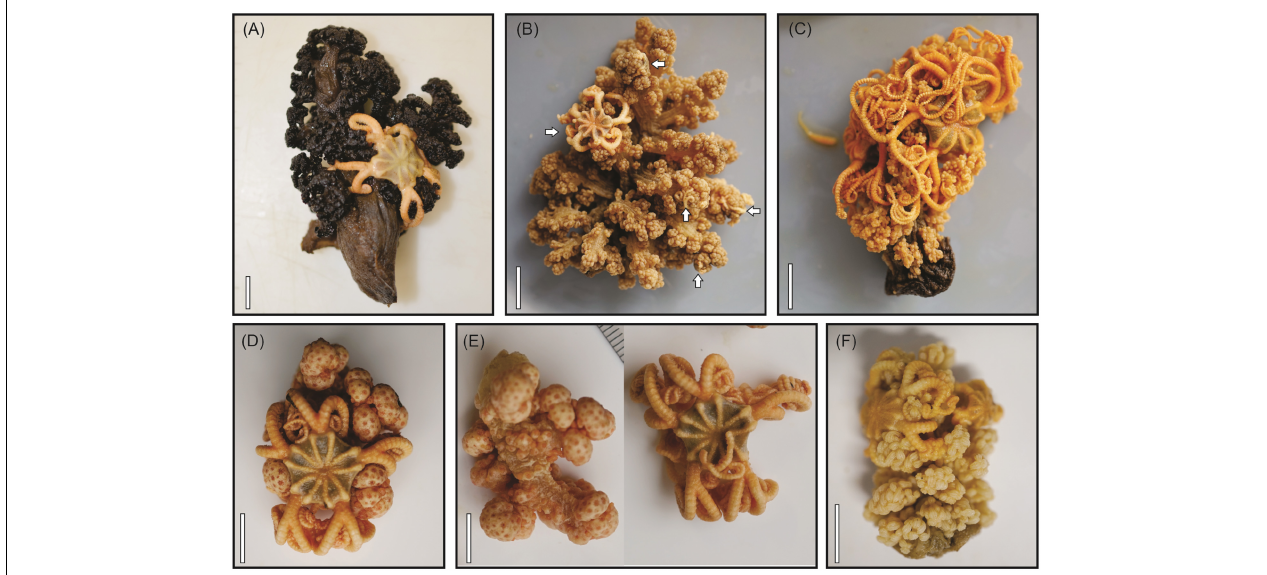
FIGURE 2 | Cold-water Nephtheidae soft corals as hosts for juvenile basket stars ( Gorgonocephalus sp.). (A) Duva florida , (B,C) Drifa glomerata , (D,E) Gersemia rubiformis , (F) Pseudodrifa racemosa . Arrows in (B) point to some of the individuals found on this colony, which contained 15 juvenile basket stars. (E) Shows the colony and basket star seen in (D) after being separated. Scale bars = 1 cm.